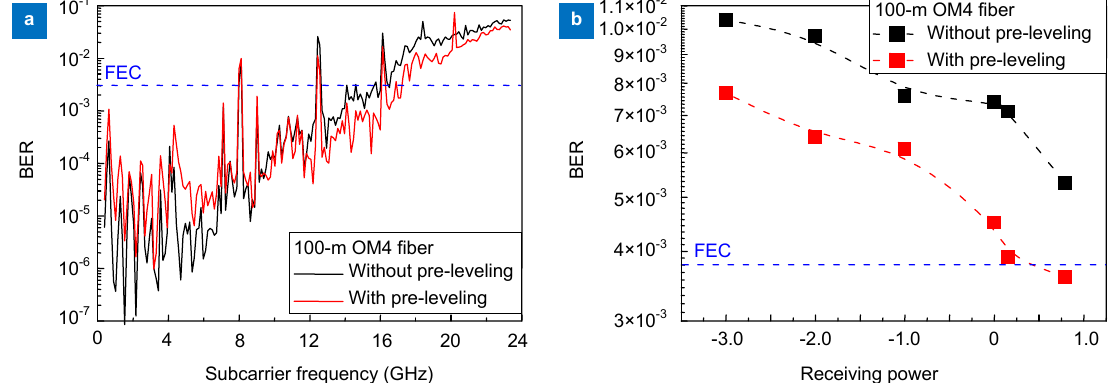
Fig. 11 | ( a ) Subcarrier BER responses of the 16-QAM OFDM data before and after 100-m MMF transmissions. ( b ) BER responses of the FM VCSEL carried 16-QAM OFDM data with and without pre-leveling under 100-m MMF transmissions under different receiving